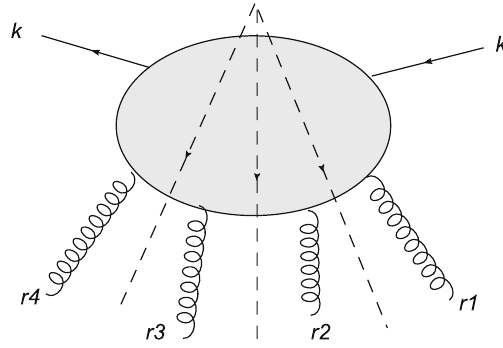
Fig. 1 Diffractive scattering off a hadron